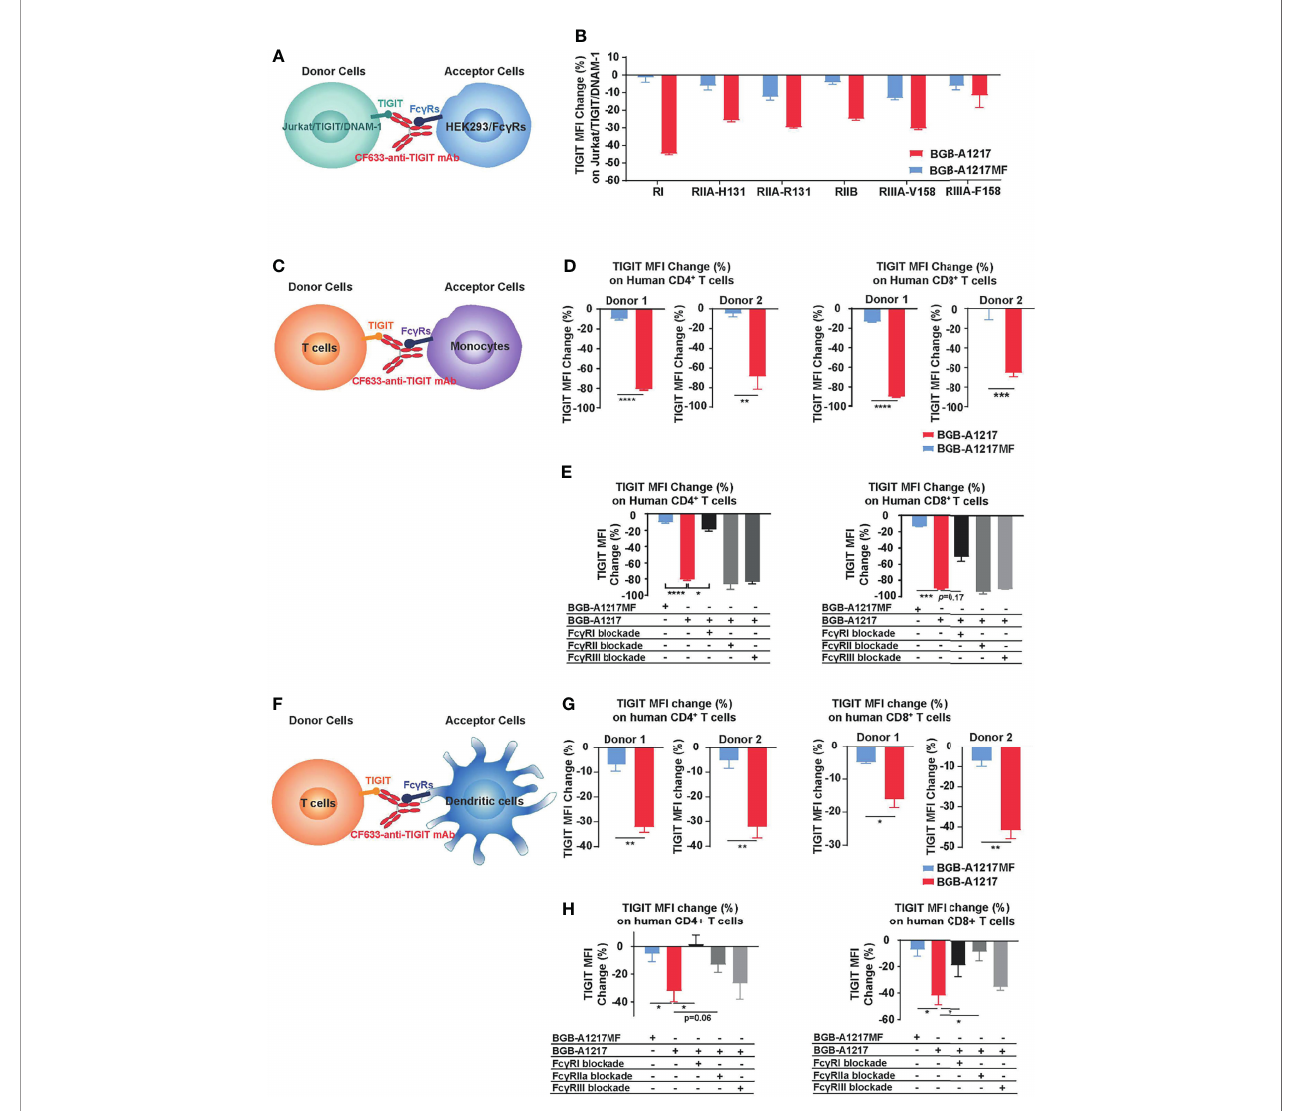
FIGURE 5 | BGB-A1217 induces trogocytosis on T cells in an Fc dependent manner. (A, B) Cell line-based trogocytosis assay. (C – H) primary cell-based trogocytosis assay. T cells with monocytes (C – E) or with DCs (F – H) isolated from the same healthy donors were incubated with 10 m g/mL CF633-labeled BGB- A1217 or CF633-labeled BGB-A1217MF overnight. Changes of TIGIT (CF633) MFI on T cells were measured by FACS. (D, G) Data from two donors. Unpaired t test was used to compare BGB-A1217 and BGB-A1217MF for each donor. N = 3. Data shown as mean ± SD. (E, H) Data from one donor as